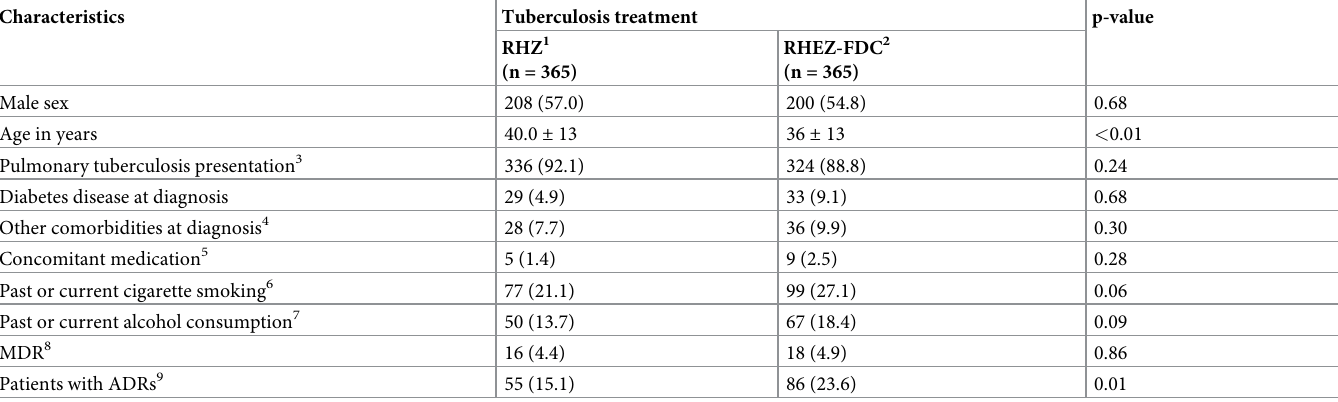
Table 1. Baseline demographic and clinical presentation of tuberculosis patients. Characteristics